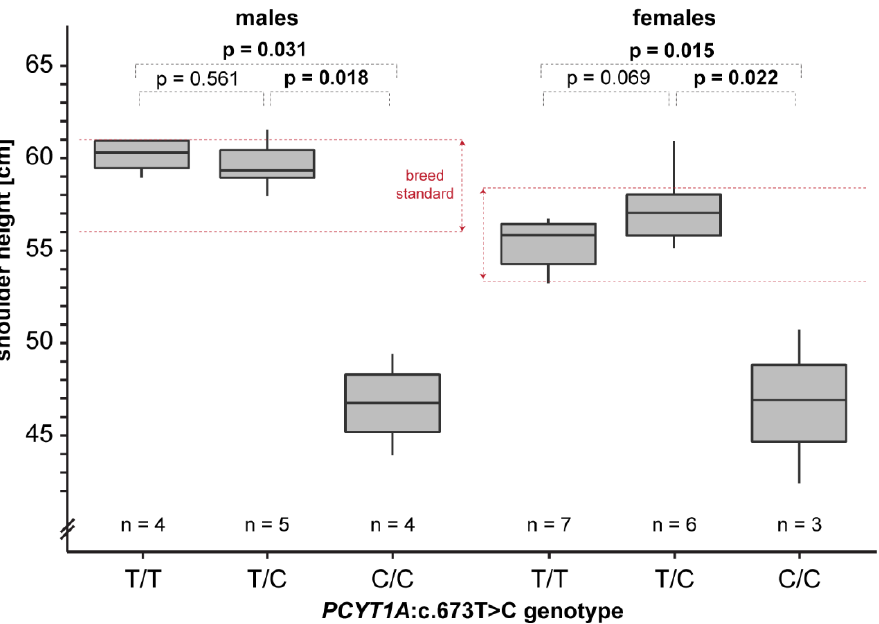
Figure 5. Genotype – phenotype correlation. Shoulder height measurements of Vizslas displayed according to their genotypes are given as box plots. Note that homozygous mutant dogs are markedly shorter than the breed standard. Pairwise permutation tests with 10,000 iterations were used to calculate p -values.